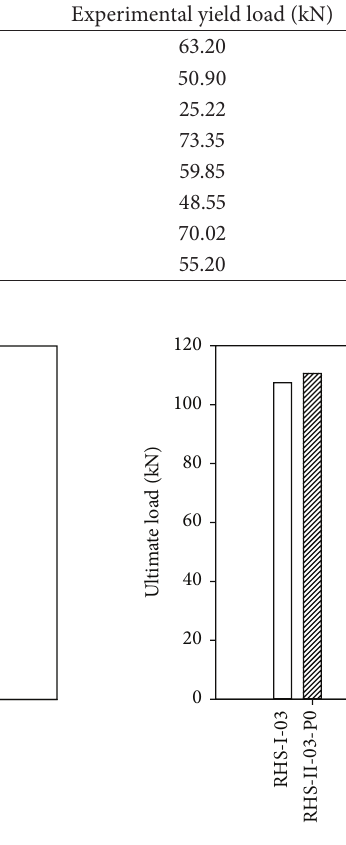
Table 3: Yield load and ultimate load.